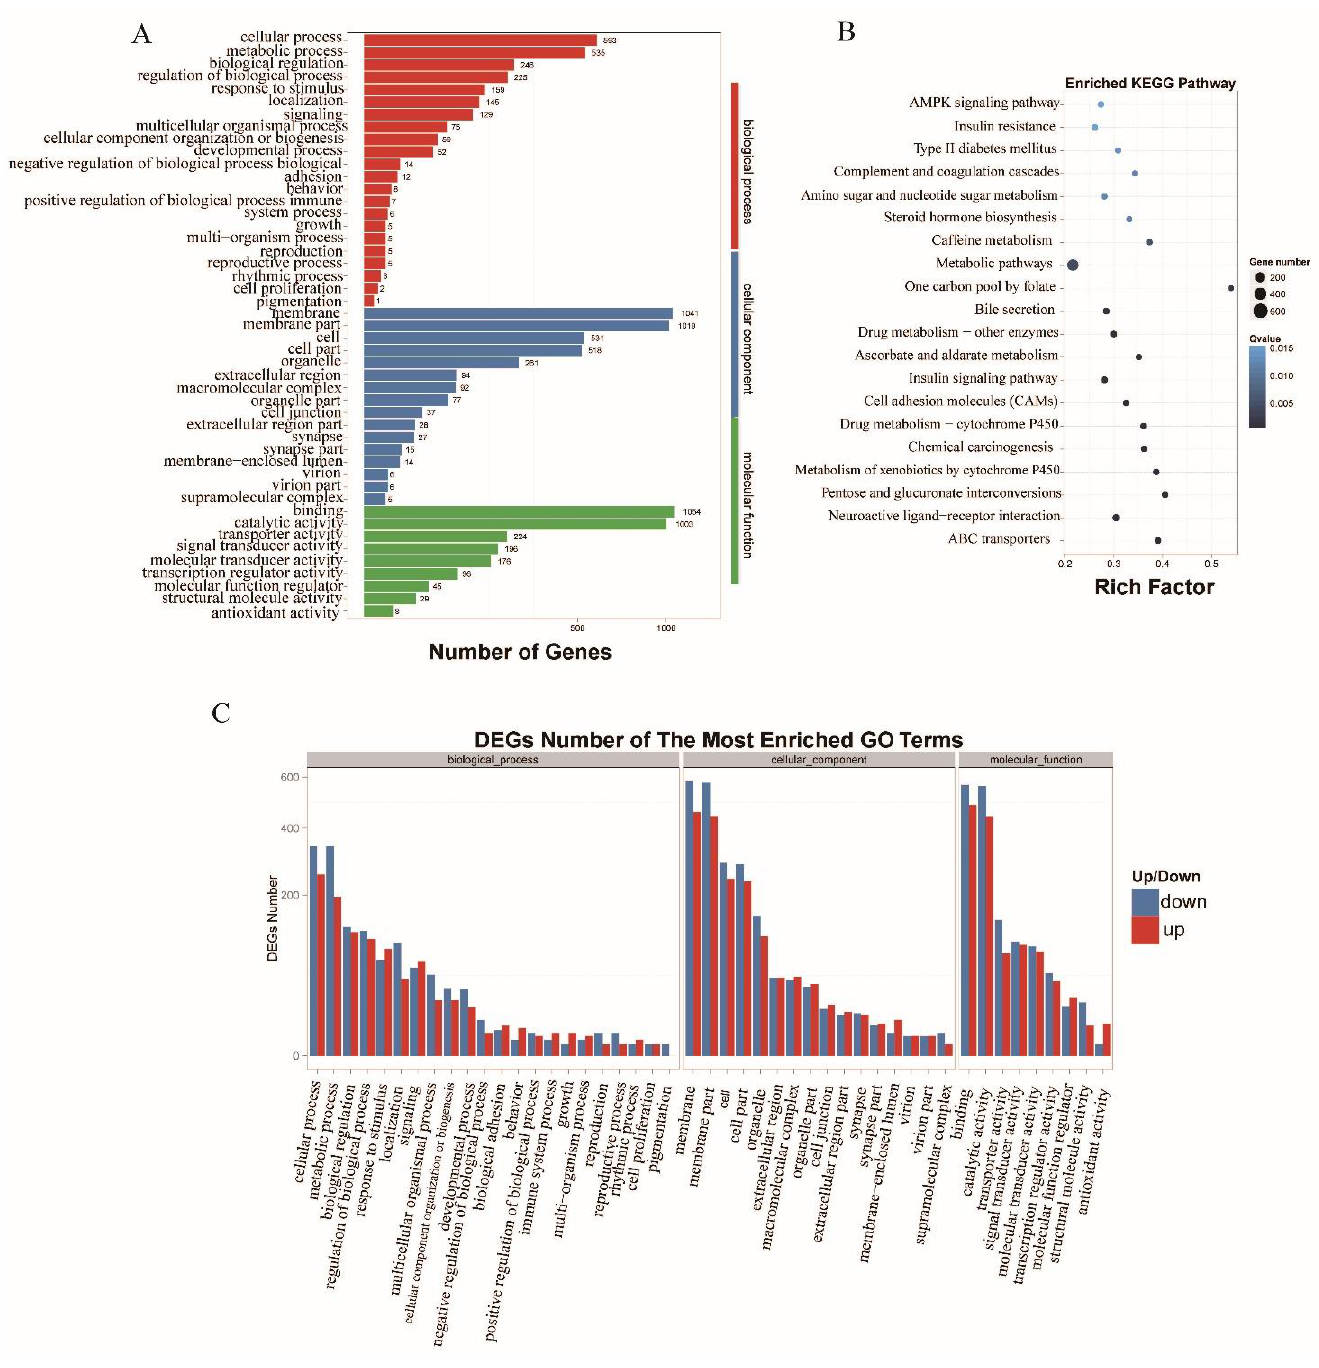
Figure 5. Statistical results for GO enrichment, the Y-axis corresponds to the GO terms, and the red histogram refers to biological process, blue is cellular components, and green is molecular functions ( A ); KEGG pathways ( B ); and up- and down-regulated GO term, where the X-axis indicates the different GO terms, down-regulation is shown in blue, and up-regulation is shown in red ( C ), of significant differential lncRNAs in Tribolium castaneum.